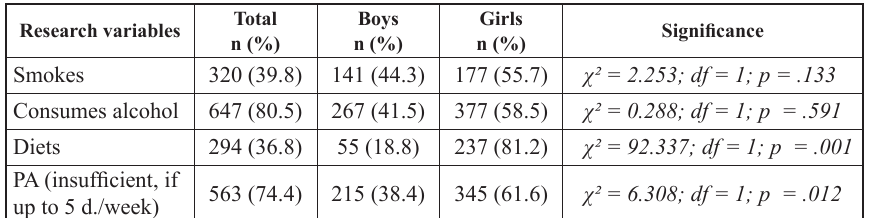
Table 2. The expression of the sociocultural attitudes towards appearance in the groups of harmful habits and physical activity